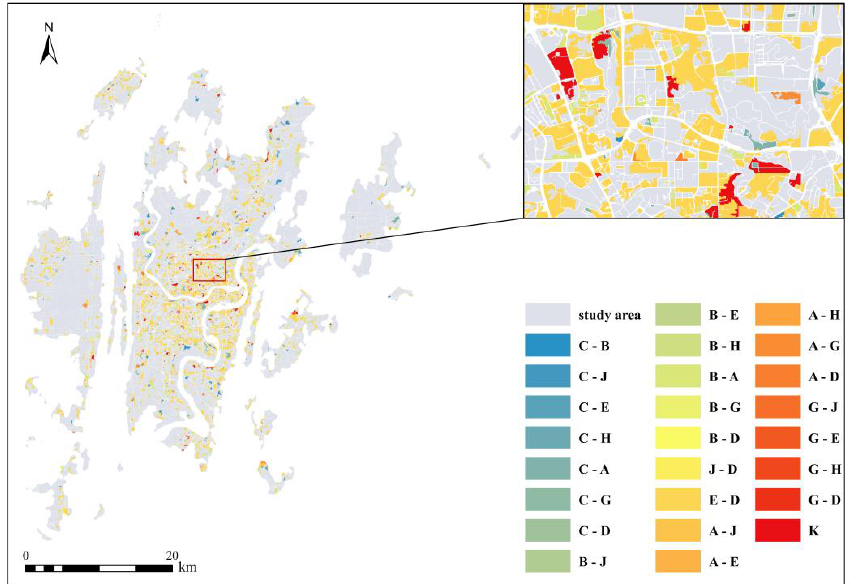
Figure 7. Distribution of mixed functional areas. A–K in the Figure represent: A, life service; B, industrial; C, transportation service; D, catering service; E, residential service; F, green spaces and squares; G, education; H, administration and public service; I, financial insurance; J, medical care; K, comprehensive functional area.